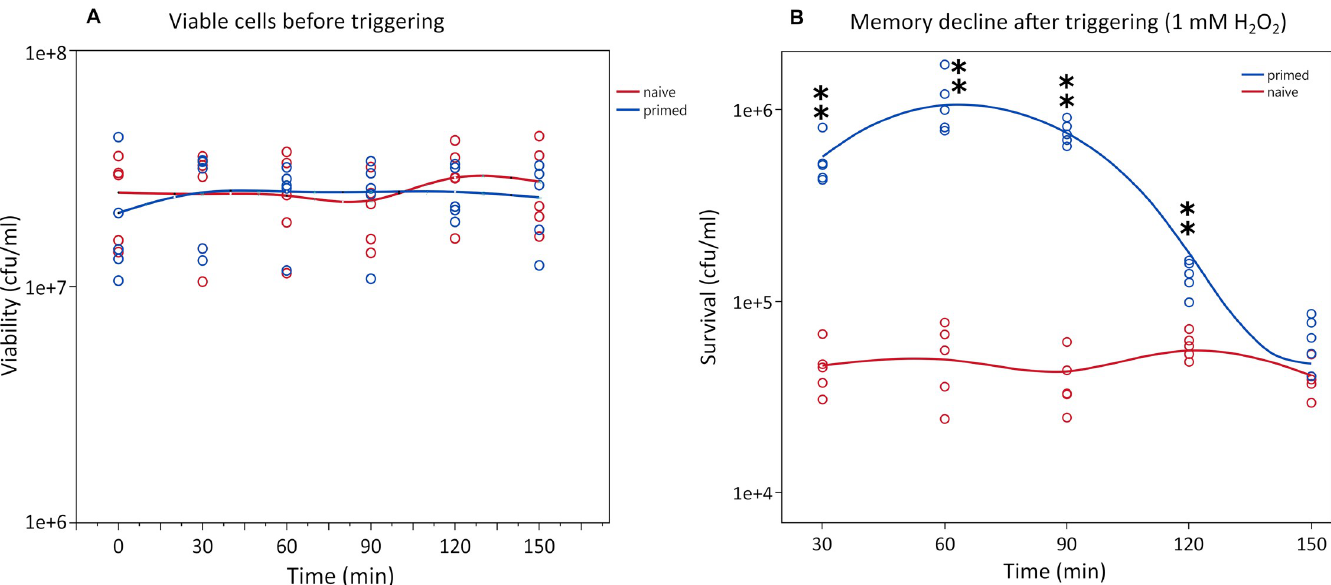
Fig 2. Bacterial survival from na ï ve and primed populations triggering at 30 minute intervals after the priming stimulus (memory of the priming response). During memory decline experiment, the viability of the cells remains unaltered before the addition of the trigger (A). The priming memory declined over time after induction of priming response with 0.1 mM H 2 O 2 (trigger) (B). Asterisks indicate significant differences between each time-point pair (Welch’s test, one asterisk for p < 0.05 and two asterisks for p <